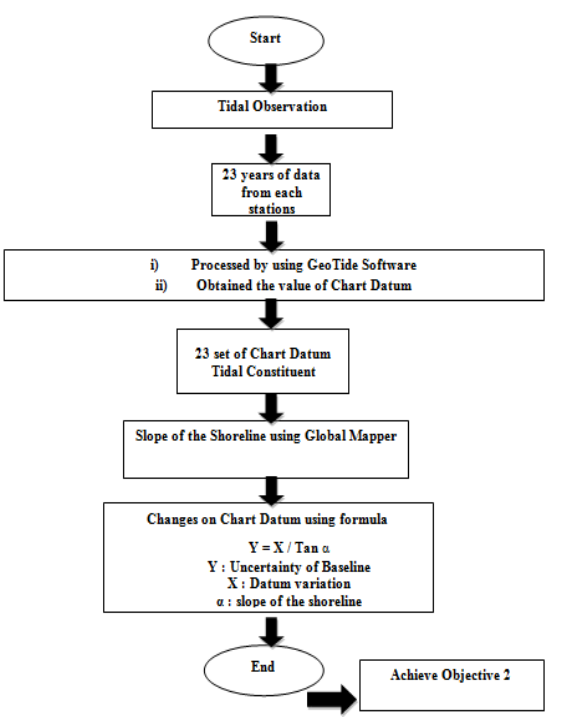
Figure 4. Methodology for Objective 2